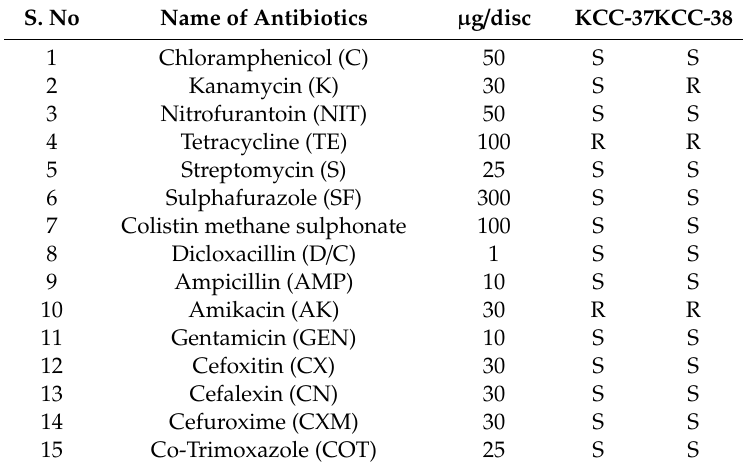
Table 3. Antibiotic sensitivity patterns for L. plantarum KCC-37 and L. plantarum KCC-38 against commercial